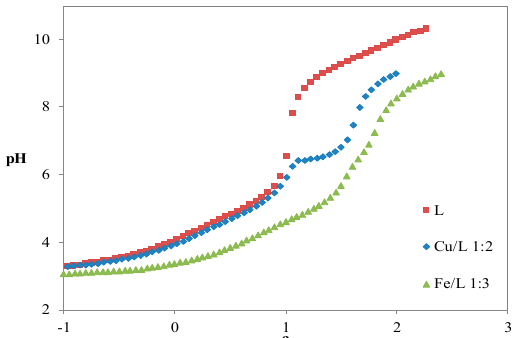
Table 2. Stepwise protonation constants of FA , 1a , and 1d as well as global formation constants a of their Fe 3+ , Cu 2+ complexes and corresponding pM b values. (T = 25.0 ± 0.1 °C, I = 0.1 M KCl, 20% w/w DMSO/water). Figure 2. Potentiometric titration curves of FA in 20% DMSO/water medium in the absence or in the presence of Cu 2+ and Fe 3+ ( C L = 5-6.7 × 10 − 4 M, a represents moles of added base per mole of ligand).